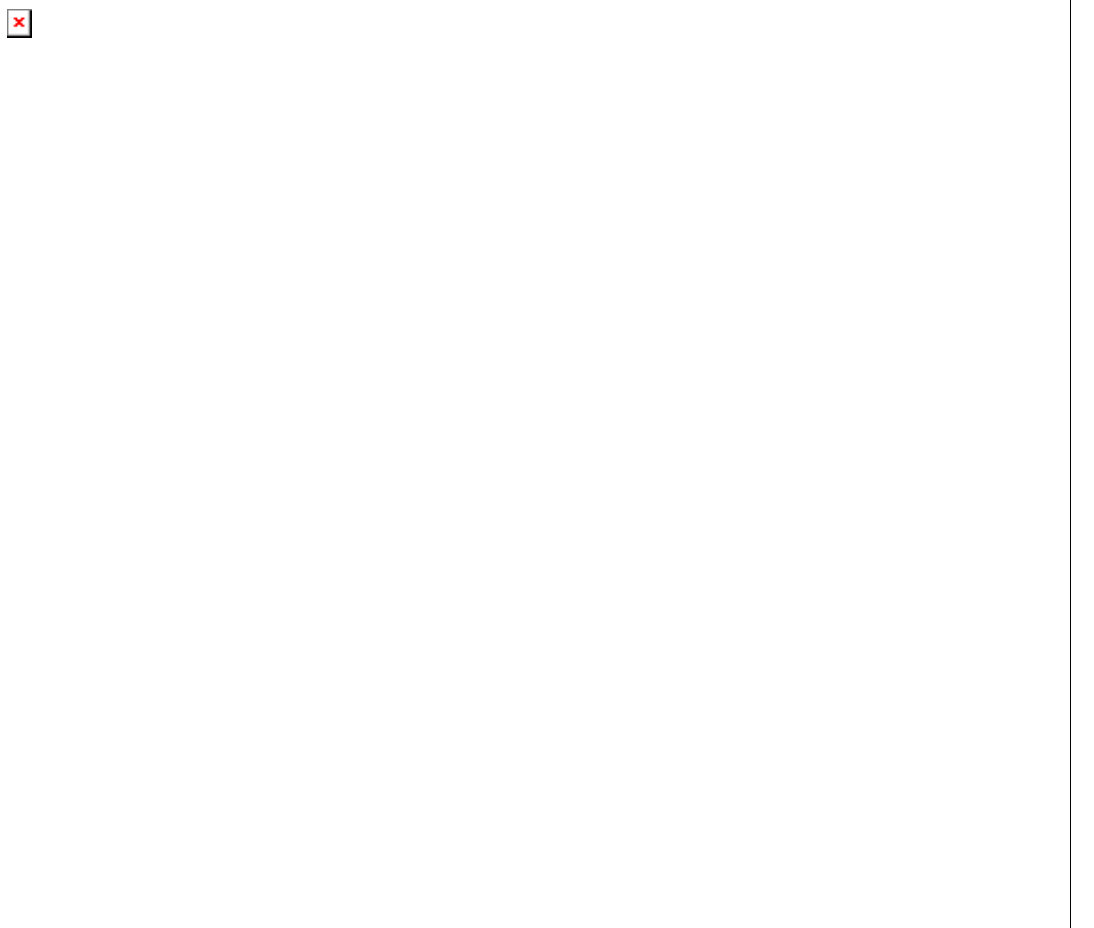
F IGURE 1. Geographical location of Ilam Province in the west of Iran and of 23 caves investigated in the study area. Numbers refer to caves as indicated in Table